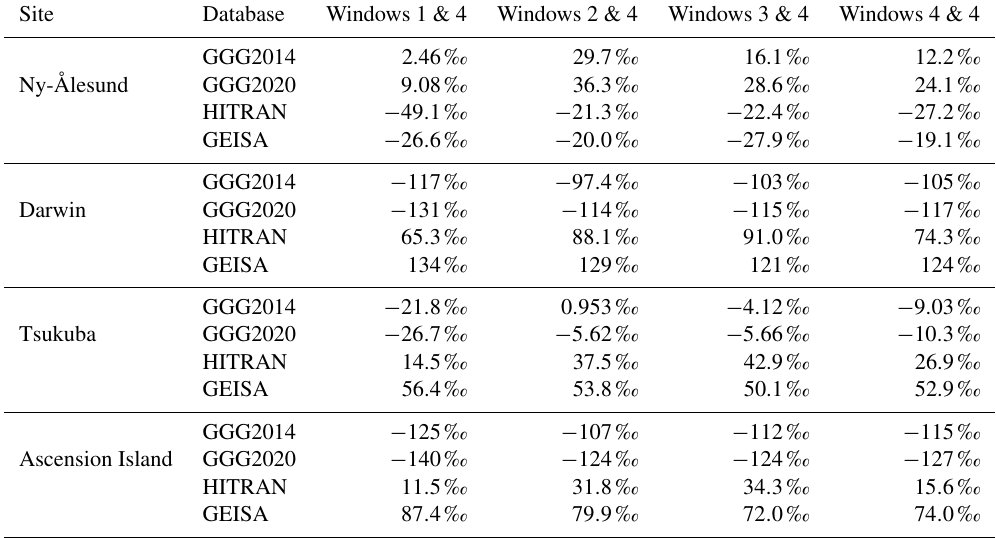
Table 5. Averaged values of δ 13 C from all TCCON sites for all possible combinations of 12 CH 4 with window 4 of 13 CH 4 for each spectral